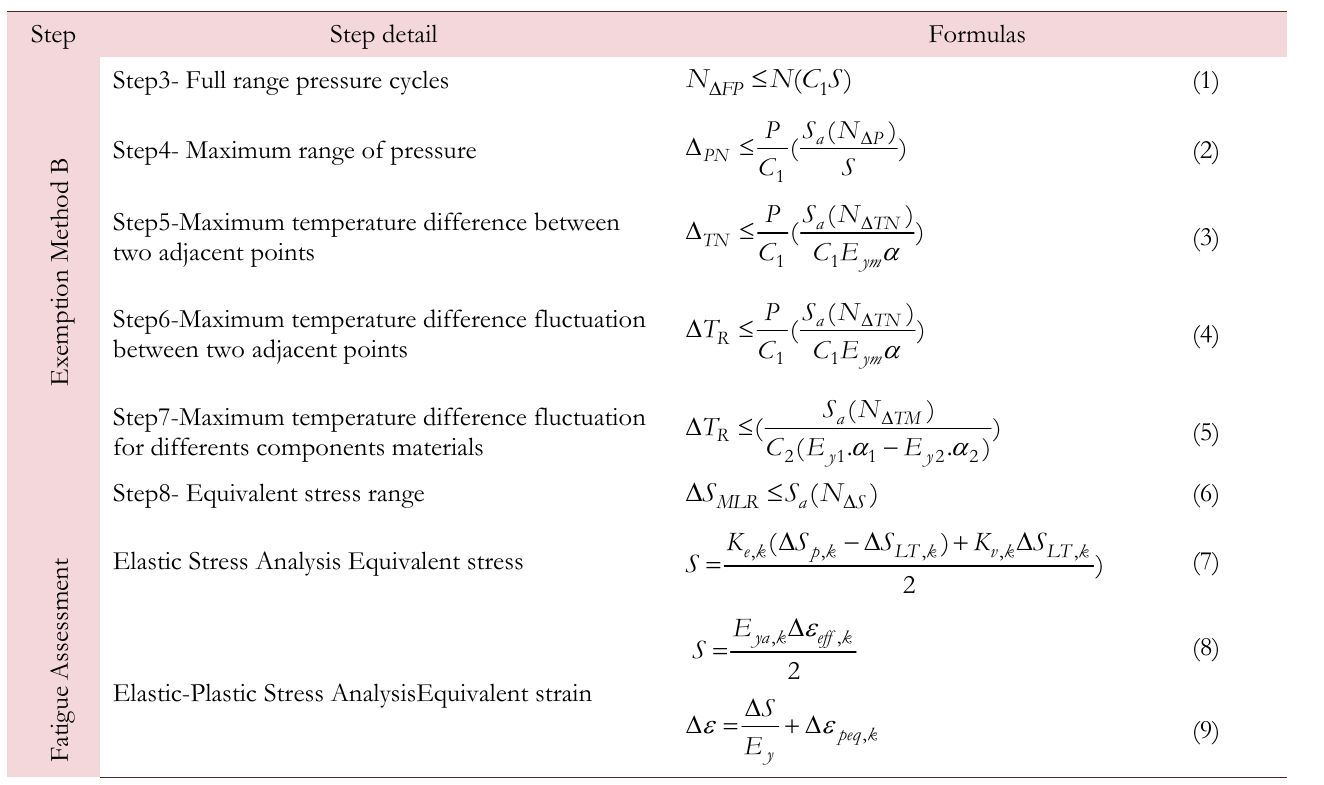
Table 1: Pressure vessels fatigue